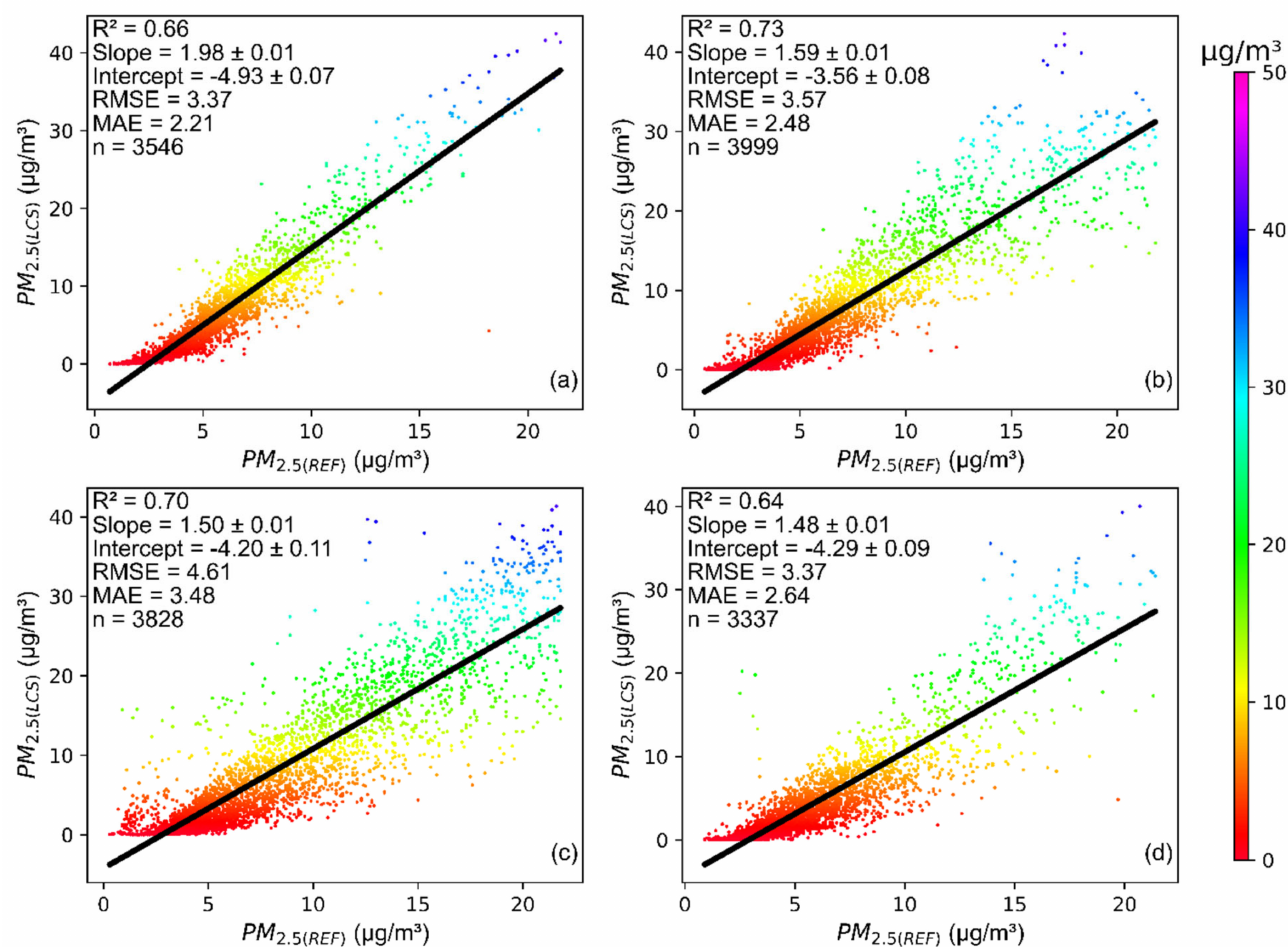
Figure 3. Comparison between PM 2.5_REF and PM 2.5_LCS for the season of ( a ) summer; ( b ) autumn; ( c ) winter; and ( d )